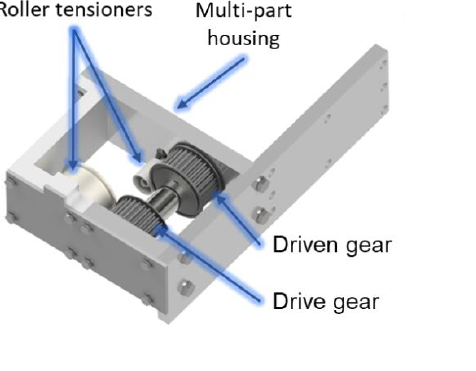
Fig. 16. View of intermediate shaft box